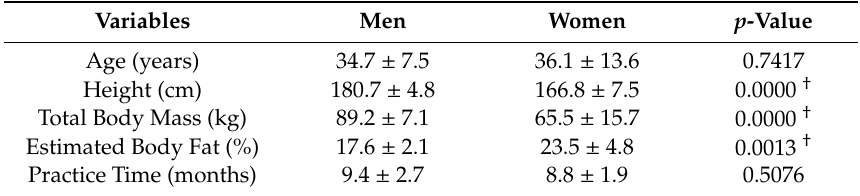
Table 2. Participants’ anthropometric measurements and practice